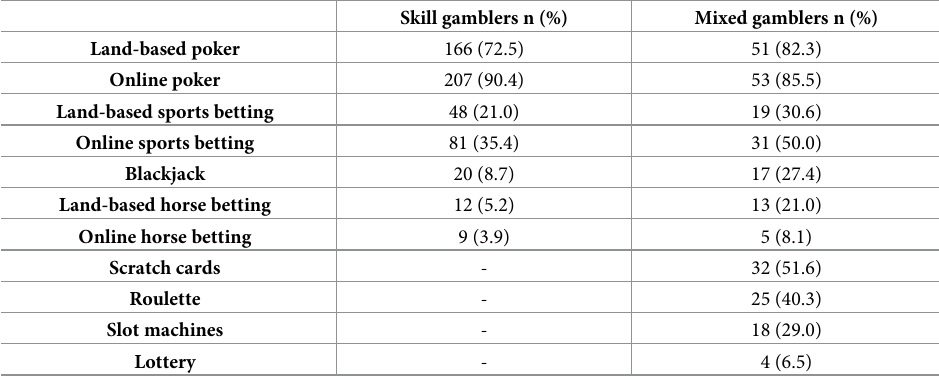
Table 2. Gamblers’ distribution by gambling